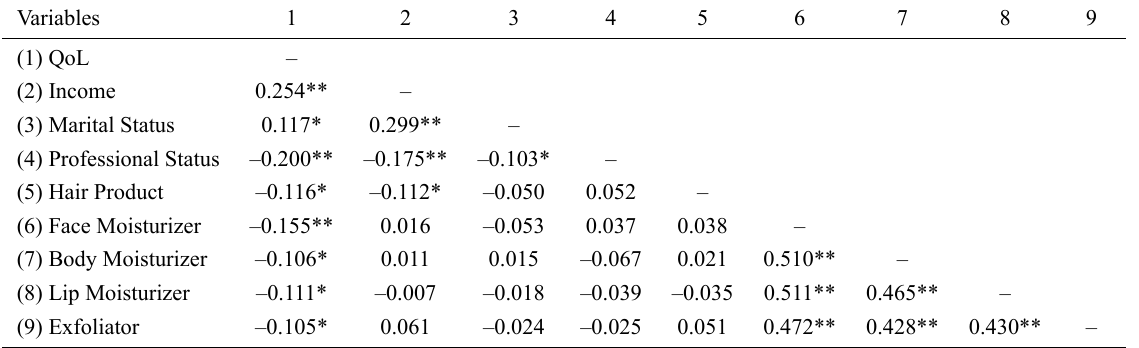
Table 1. Statistical significant relationships between sociodemographic variables, cosmetic products and QoL.